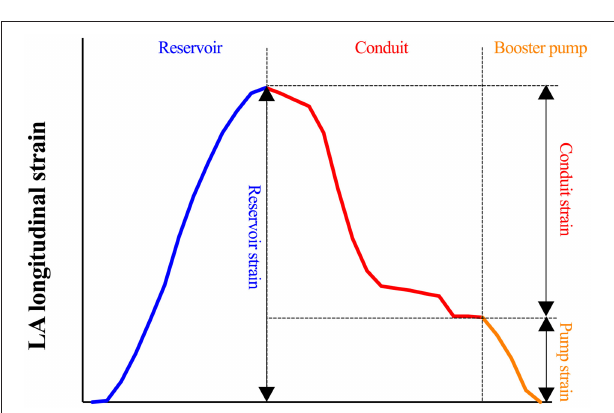
FIGURE 2 | Representative plot illustrating the calculation of reservoir, conduit and pump LALS in Figure 1F